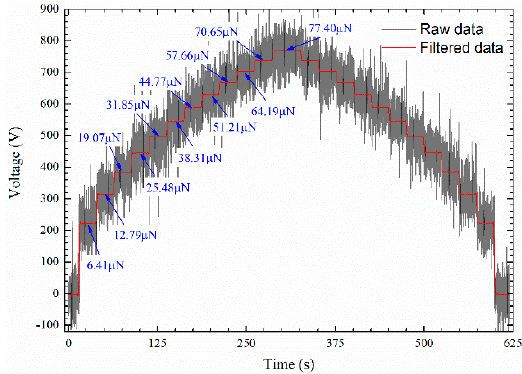
Figure 12. Voltage profile applied to the electrostatic comb.